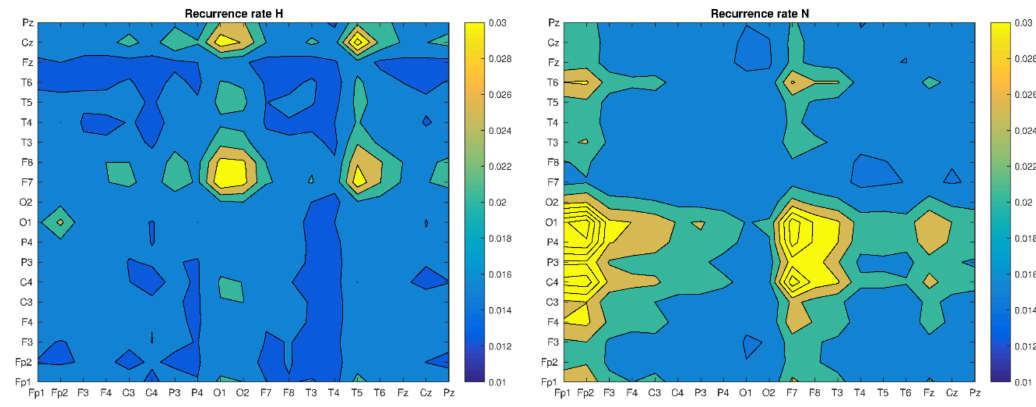
Figure 3. Mean of the Recurrence rate matrix of four trails for all bands: H, N, SN and S, respectively.